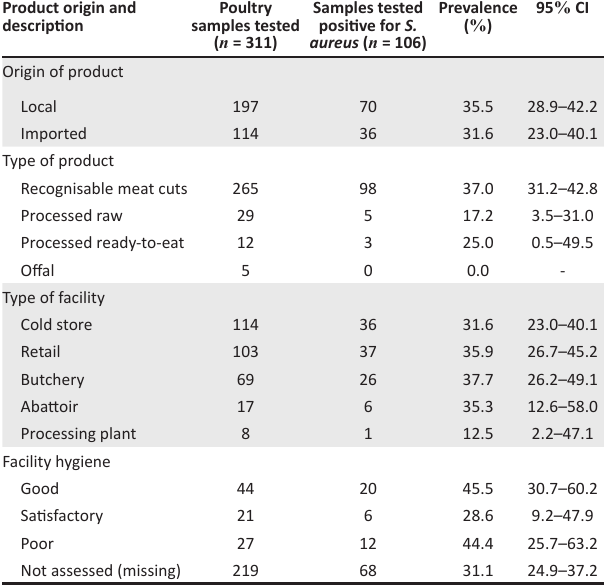
TABLE 2: Prevalence of Staphylococcus aureus in poultry meat products, South Africa, 2015–2016. Product origin and